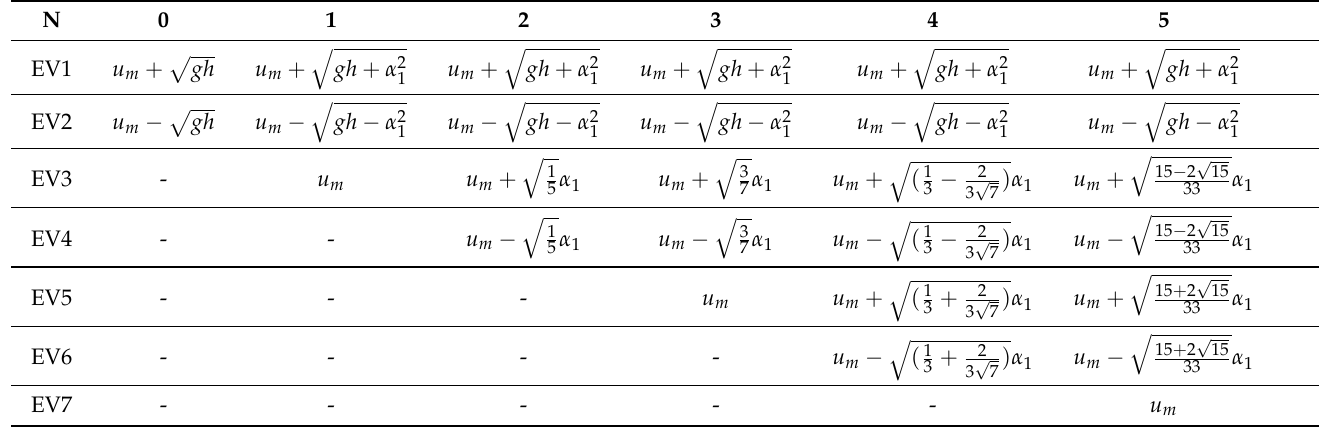
Table A1. Eigenvalues of HSWME system matrix A H (7) for N = 0, . . .